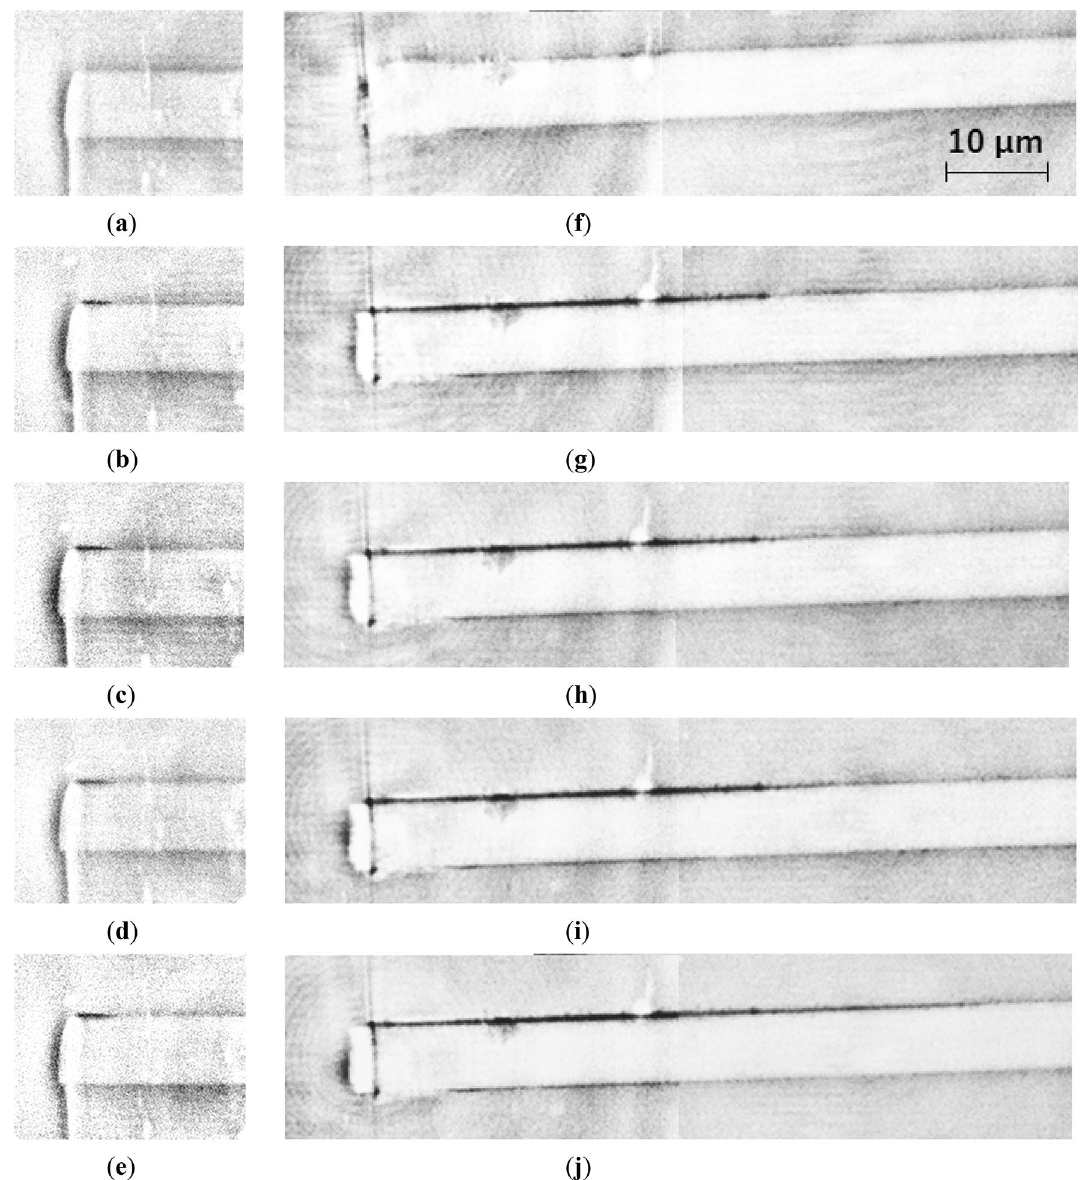
Figure 11. Transmission images obtained under cyclic loadings (stress ratio R = 0.2) with the maximum stresses of ( a )–( e ) 30 and ( f )–( j ) 40 MPa. The images were captured ( a , f ) before loading and at ( b , g ) 1; ( c , h ) 10,000; ( d , i ) 30,000; and ( e , j ) 100,000 cycles, respectively. The interfacial debonding did not propagate under 30 MPa, but finally propagated after 10,000 cycles at the maximum stress of 40